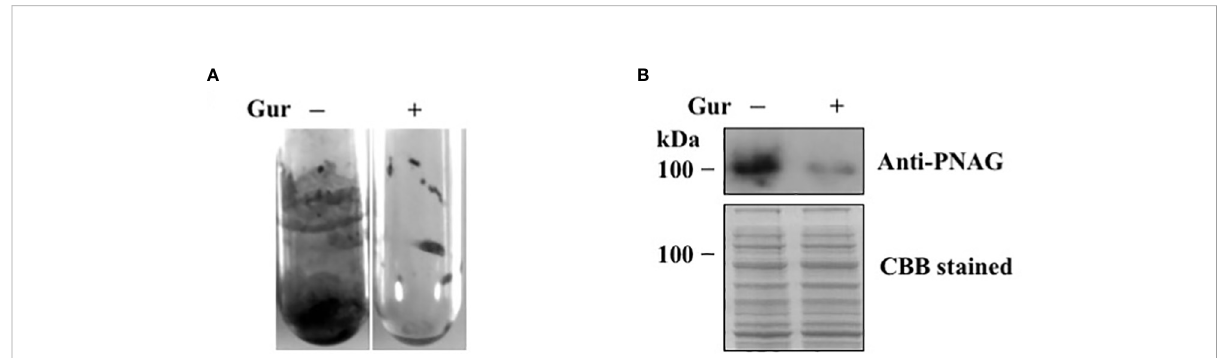
FIGURE 2 Inhibition of Sa bio fi lm growth and synthesis of polysaccharide by gurmarin polypeptide. (A) Sa bio fi lm growth was determined with puri fi ed gurmarin (1 µg/ml) in glass test tubes and TSB with gentle shaking (100 rpm) for 16 h at 37°C. After removing the medium and unbound cells, the bio fi lm was stained with crystal violet (0.1%). (B) Immunoblot analysis of N-acetylglucosamine polysaccharide from control and gurmarin- treated Sa bio fi lms. Control and gurmarin-treated Sa bio fi lm cell lysates with equal amounts of protein content were resolved on SDS-PAGE and immunoblotted with anti-PNAG antibody (upper panel). Bio fi lm proteins separated on SDS-PAGE similarly and stained with Coomassie brilliant blue (CBB) are also shown (lower